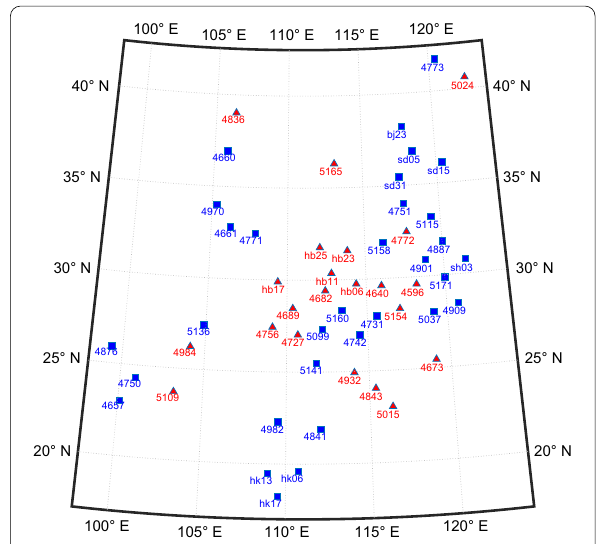
Fig. 1 Distribution of 32 reference (blue square) and 22 user sites (red